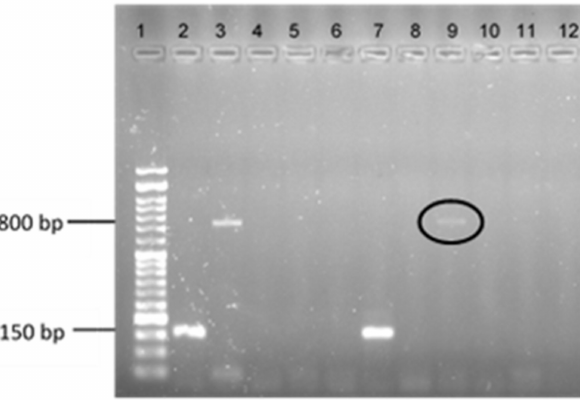
Figure 1. Electrophoresis results of a multiplex PCR reaction to determine the presence of the